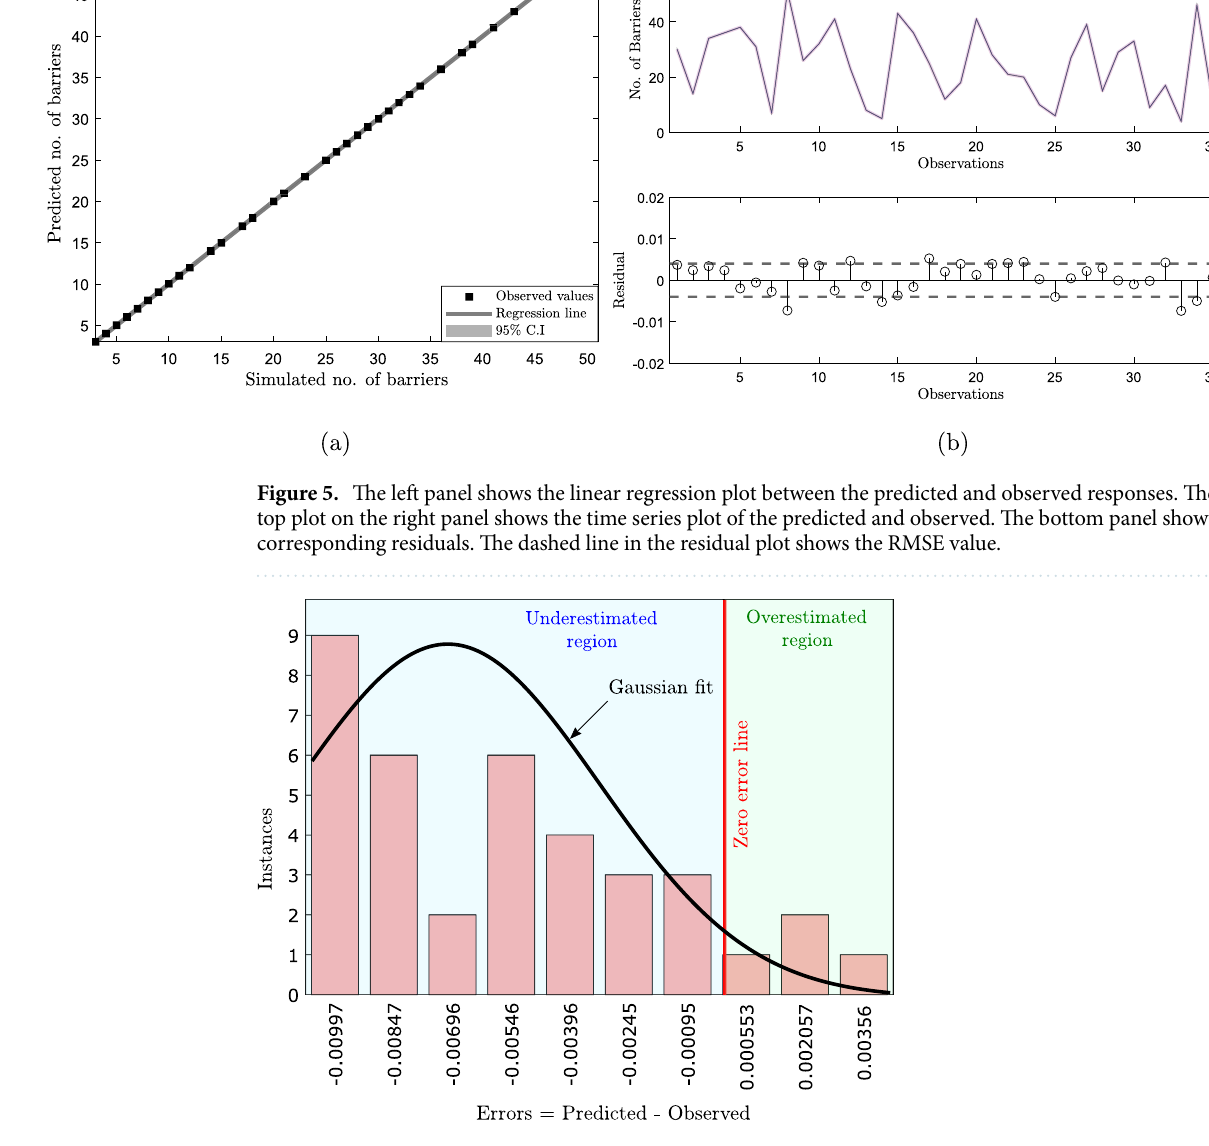
Figure 6. Error analysis using error histogram of 10 bins. The line in red shows the zero error line. The area to the left of the zero error line shows the underestimated region, and the area right to the zero error line shows the overestimated region.